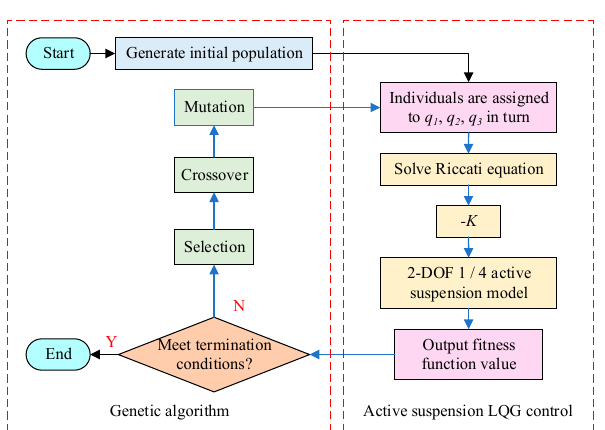
Figure 4. GA optimization for the LQR active suspension.